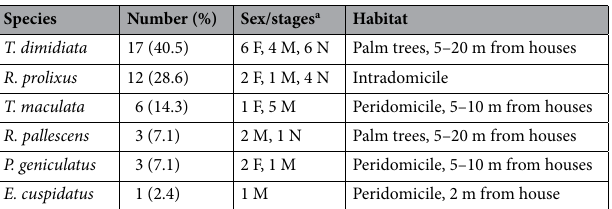
Table 1. Triatomine species in the study area. F female, M male, N nymph. a The sex of six adult bugs could not be determined (one T. dimidiata and five R. prolixus